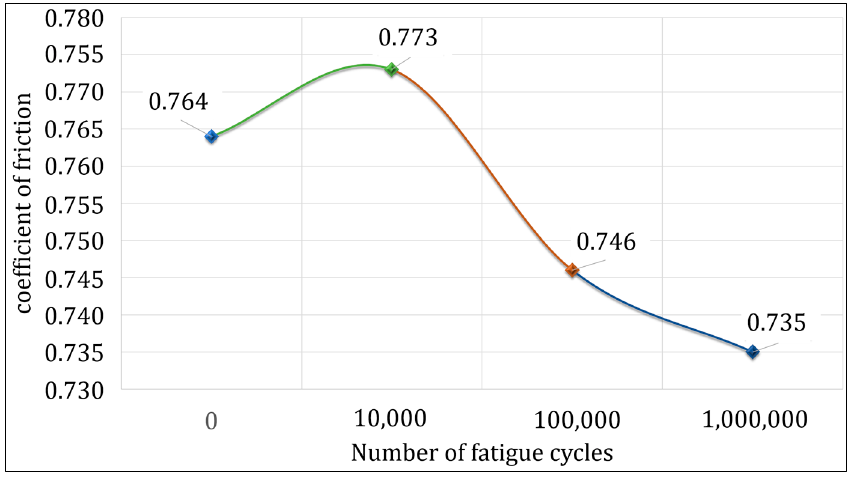
Figure 6. Change of the coefficient of friction depending on the number of fatigue cycles.